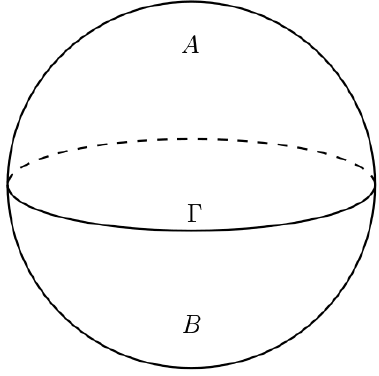
Figure 2 . The sphere is cut into hemispheres A and B by an entangling cut at the